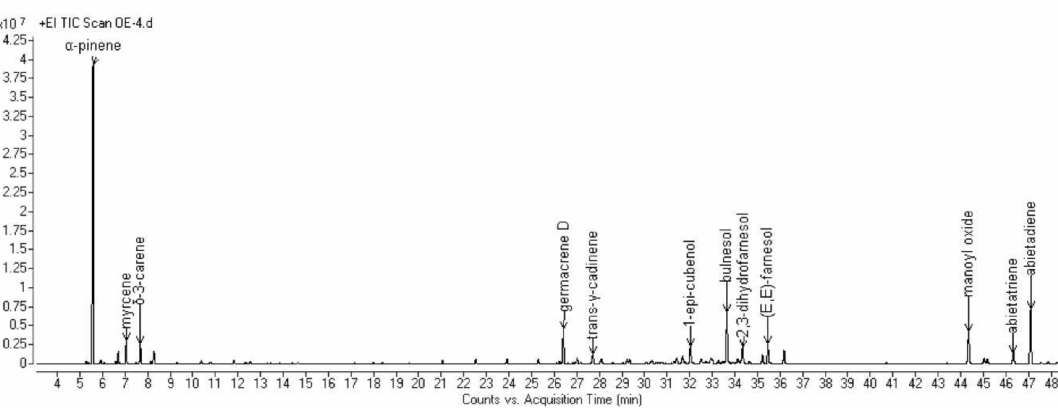
Figure 4. GC chromatogram of the EO hydrodistilled from the aerial parts of J. oxycedrus L. M. pulegium EO contained twenty-six volatile constituents, representing 96.8% of the total. Its